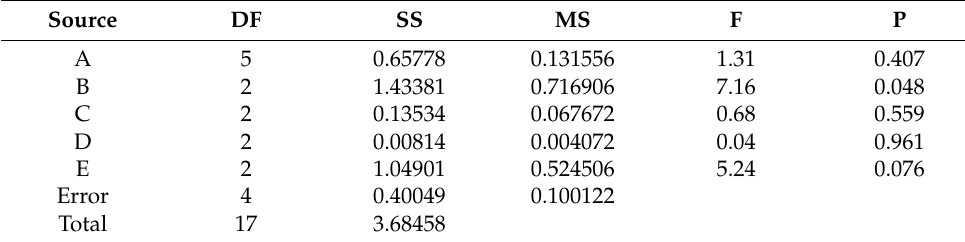
Table 6. Analysis of variance for the orthogonal experiment (warpage deformation).